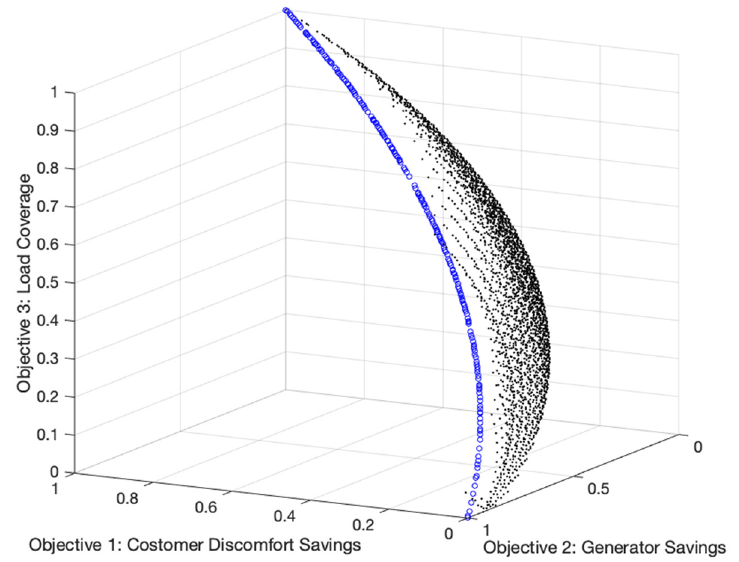
Figure 5. All feasible solutions and the optimal solutions on the Pareto frontier .